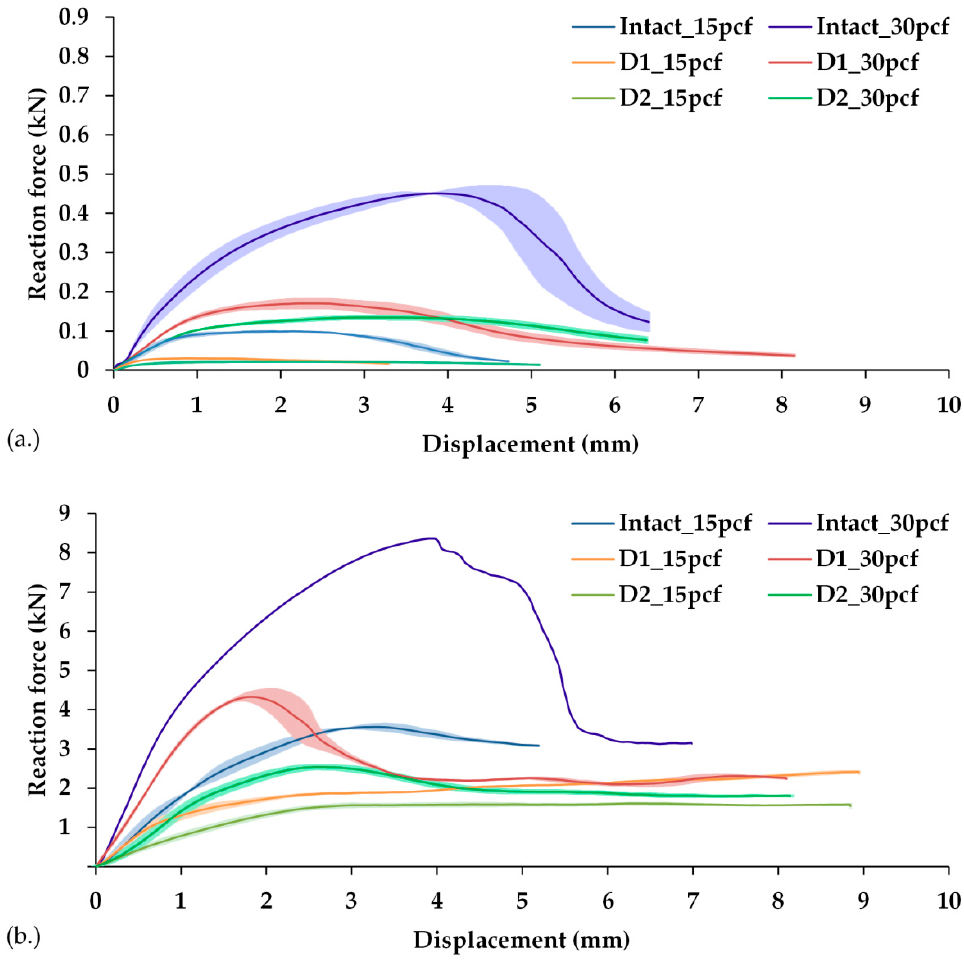
Figure 9. Force–displacement curves determined using Method 1 ( a ) and Method 2 ( b ) for tilting the acetabular cups from all the cavity types at 15 pcf and 30 pcf foam densities. For qualitative comparison, the curves are represented by their mean values ( n = 3) for each cavity type-foam density combination, and the colored area around the curve represents the SD. The only exception in the force–displacement curves is for the intact cavity in the foam block of 30 pcf density in Method 2. Moreover, due to the occurrence of plastic deformation at the rim of the acetabular cup, only one cup could be tested. For reasons of better visibility, the scaling of both graphs was adjusted to the determined values.